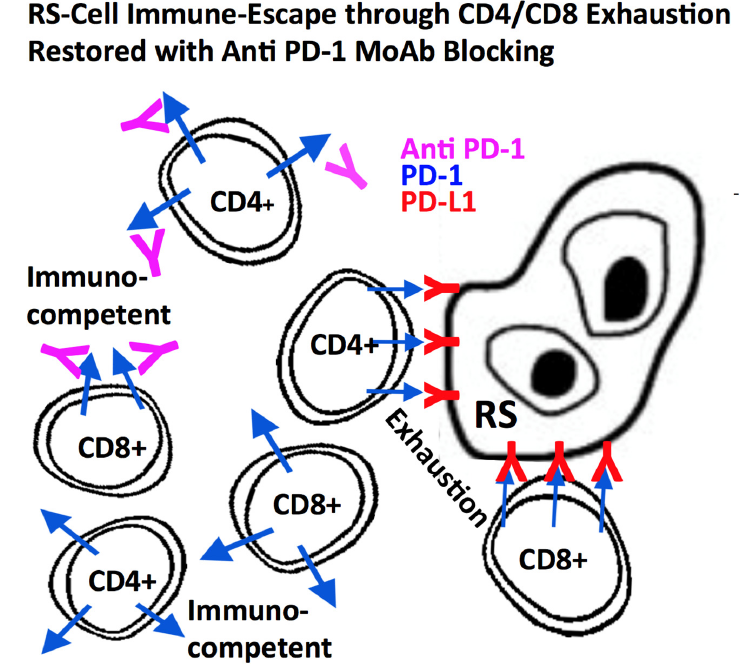
Figure 2. Hodgkin (H) and Reed ‐ Sternberg (RS) ‐ cells (especially LMP1+) express a high number